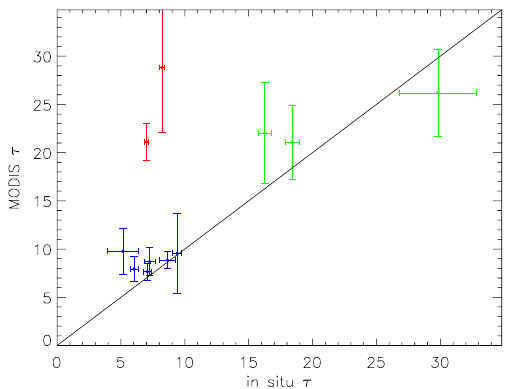
Fig. 4. Comparison of τ c retrieved by MODIS and in situ measured τ . Vertical error bars represent the standard deviation of MODIS τ across the 5 × 5km comparison domain. Horizontal error bars rep- resent the propagated bin location calibration error. Red points are clouds whose 2DS LWPs were > 10gm − 2 , green points have a 2DS LWP in the range 1–10gm − 2 and blue points have a 2DS LWP < 1gm −